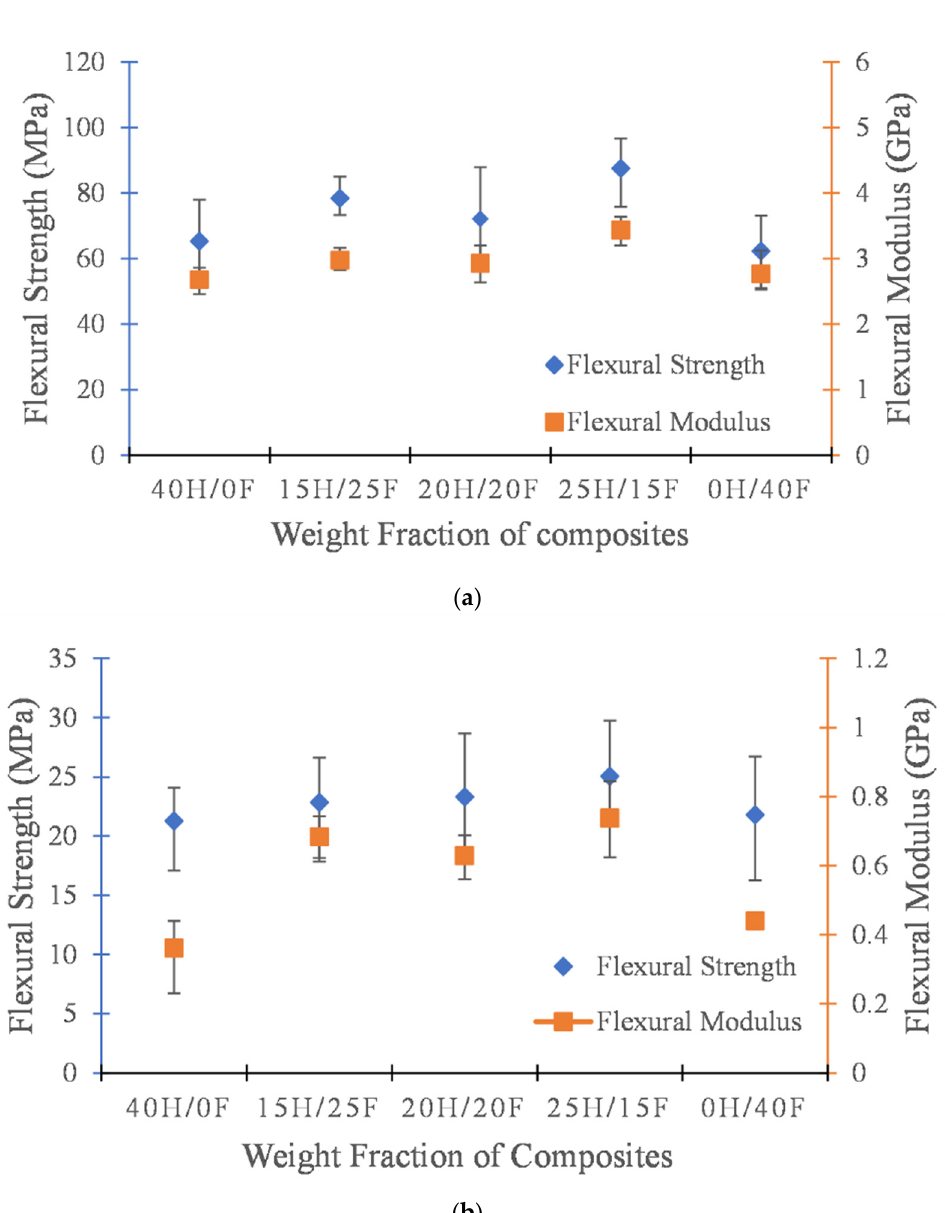
Figure 2. Flexural strength and modulus of H/F hybrid composites with epoxy ( a ) and Ecopoxy ( b ) matrices.